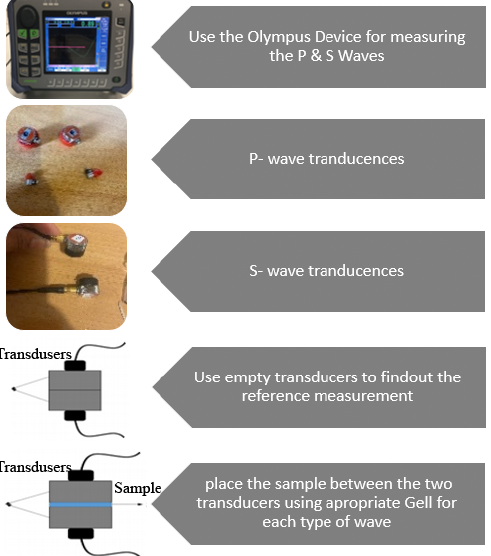
Figure 10. Flowchart representing a scheme with the connections and sensors, and a representation of the experimental measurements and procedure.